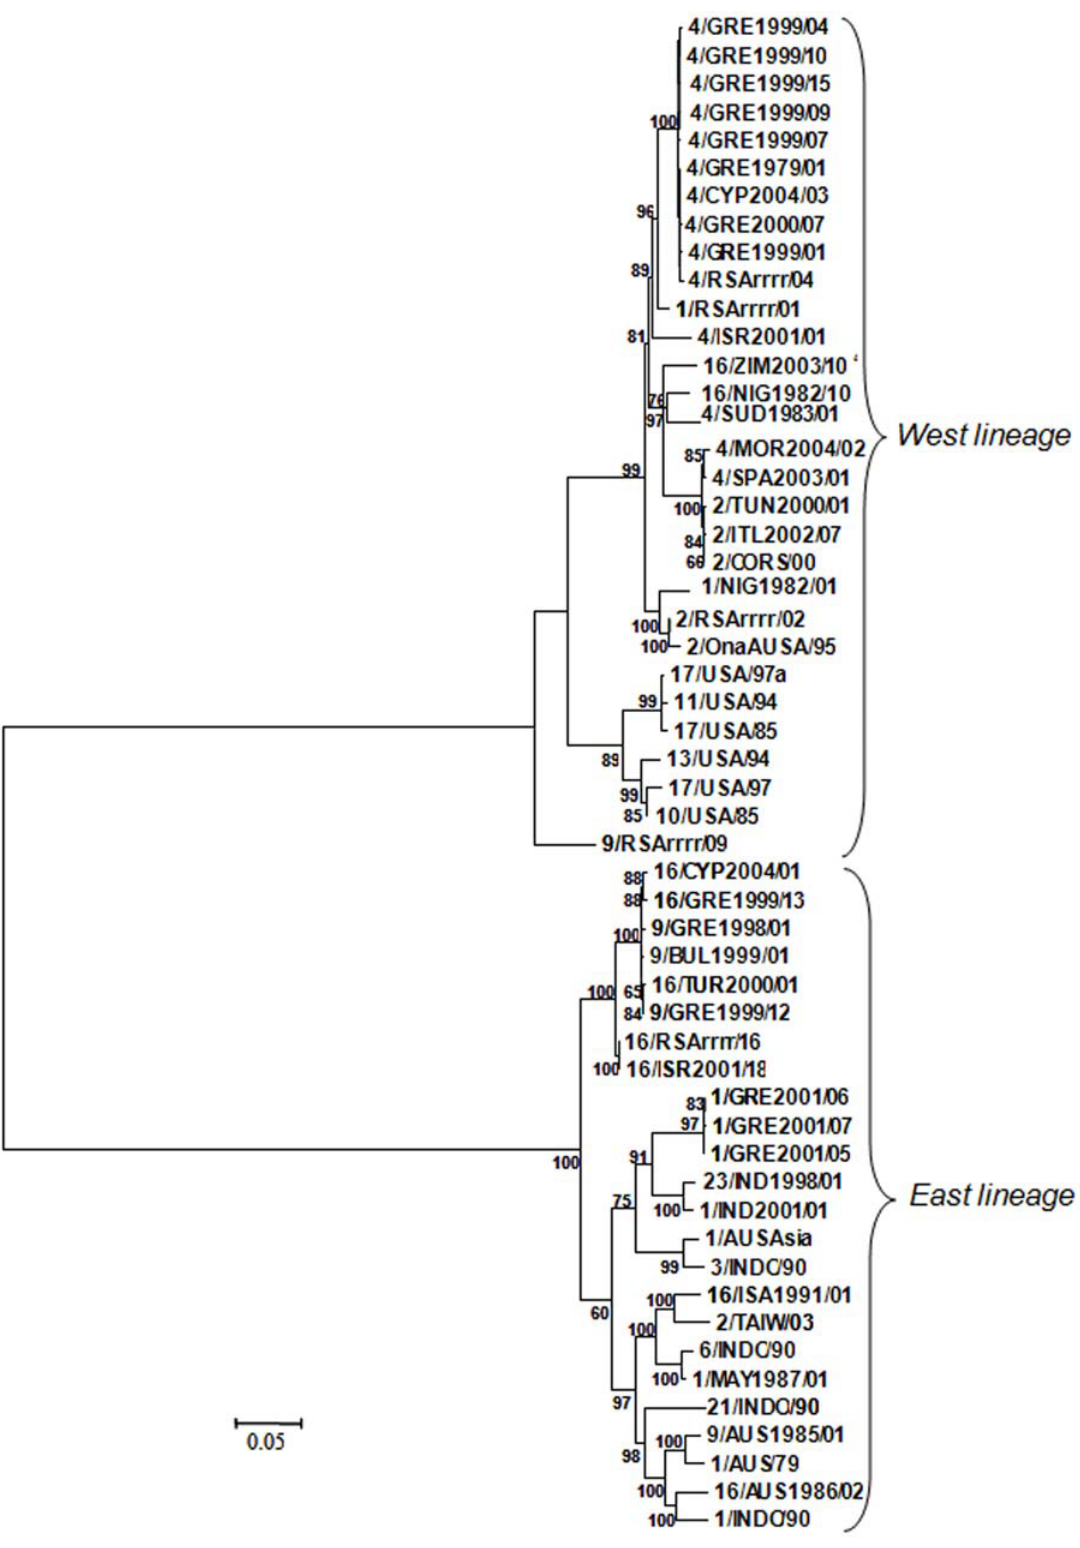
Figure 3. Phylogenetic tree constructed using maximum likelihood analyses using the whole coding region of BTV Seg-3 and the GTR + I + C model. The viruses included are listed intables 1 and 2. Isolate abbreviations: Serotype/origin (GRE: Greece, ISR: Israel, ZIM: Zimbabwe, NIG: Nigeria, SUD: Sudan, MOR: Morocco, SPA: Spain, TUN: Tunisia, ITL: Italy, CORS: Corsica, USA: USA, CYP: Cyprus, BUL: Bulgaria, TUR: Turkey, IND: India, AUSAsia: Australasia, INDO: Indonesia, TAIW: Taiwan, MAY: Malaysia, AUS: Australia, ISA: Indonesia, RSA: Reference strain)/year of isolation or IAH dsRNA virus reference collection number. The tree is midpoint rooted for purposes of clarity. The numbers indicated on branches are non- parametric bootstrap (NPB) probabilities and only values with P . 0.6 are shown.